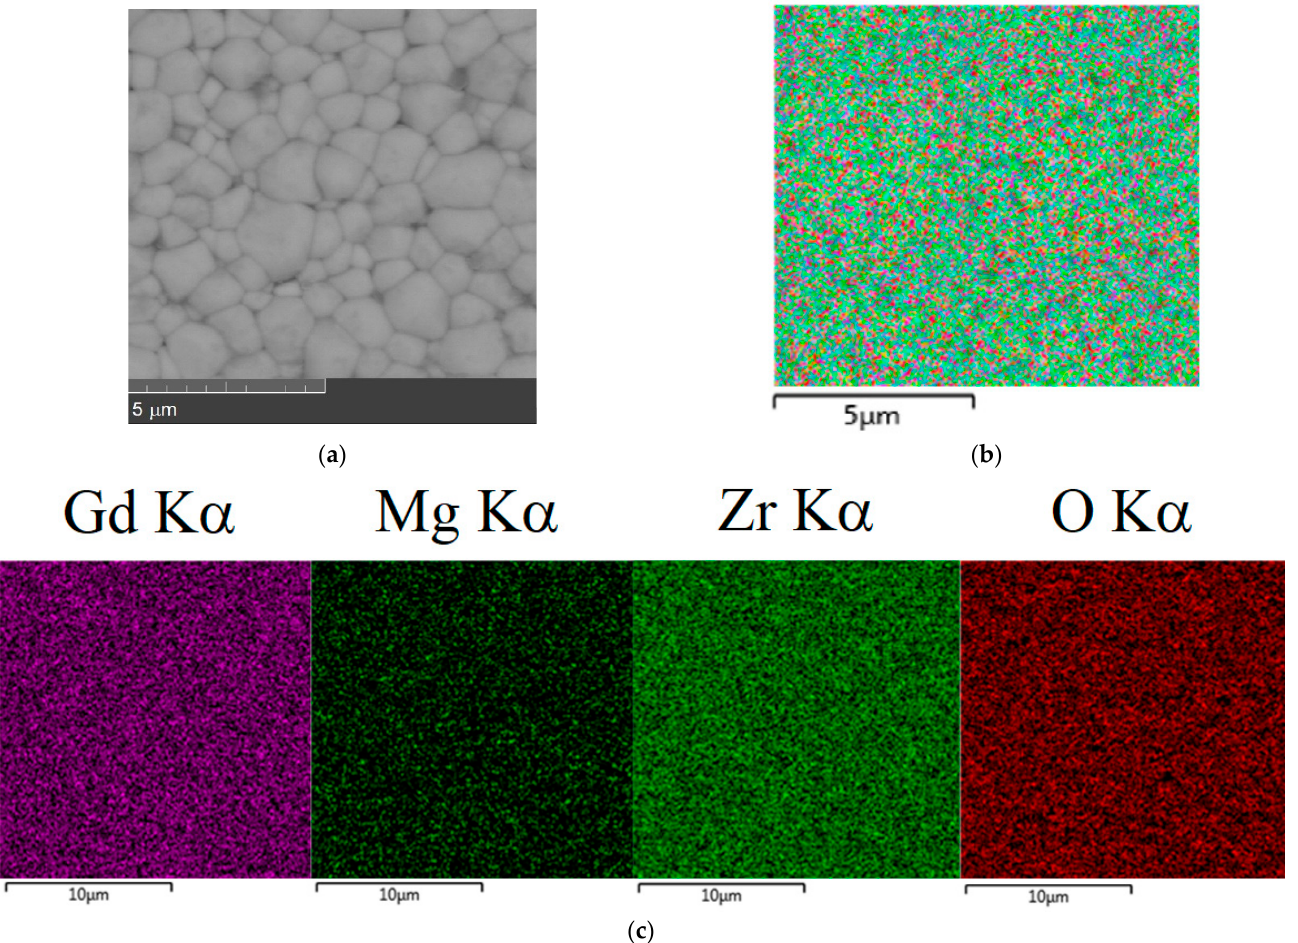
Figure 2. SEM images of Gd 2 − x Mg x Zr 2 O 7 − x/2 (x = 0.05) ( a ) and elemental mapping ( b ); gadolinium, magnesium, zirconium, and oxygen distribution for Gd 2 − x Mg x Zr 2 O 7 − x/2 (x = 0.05) ( c ).